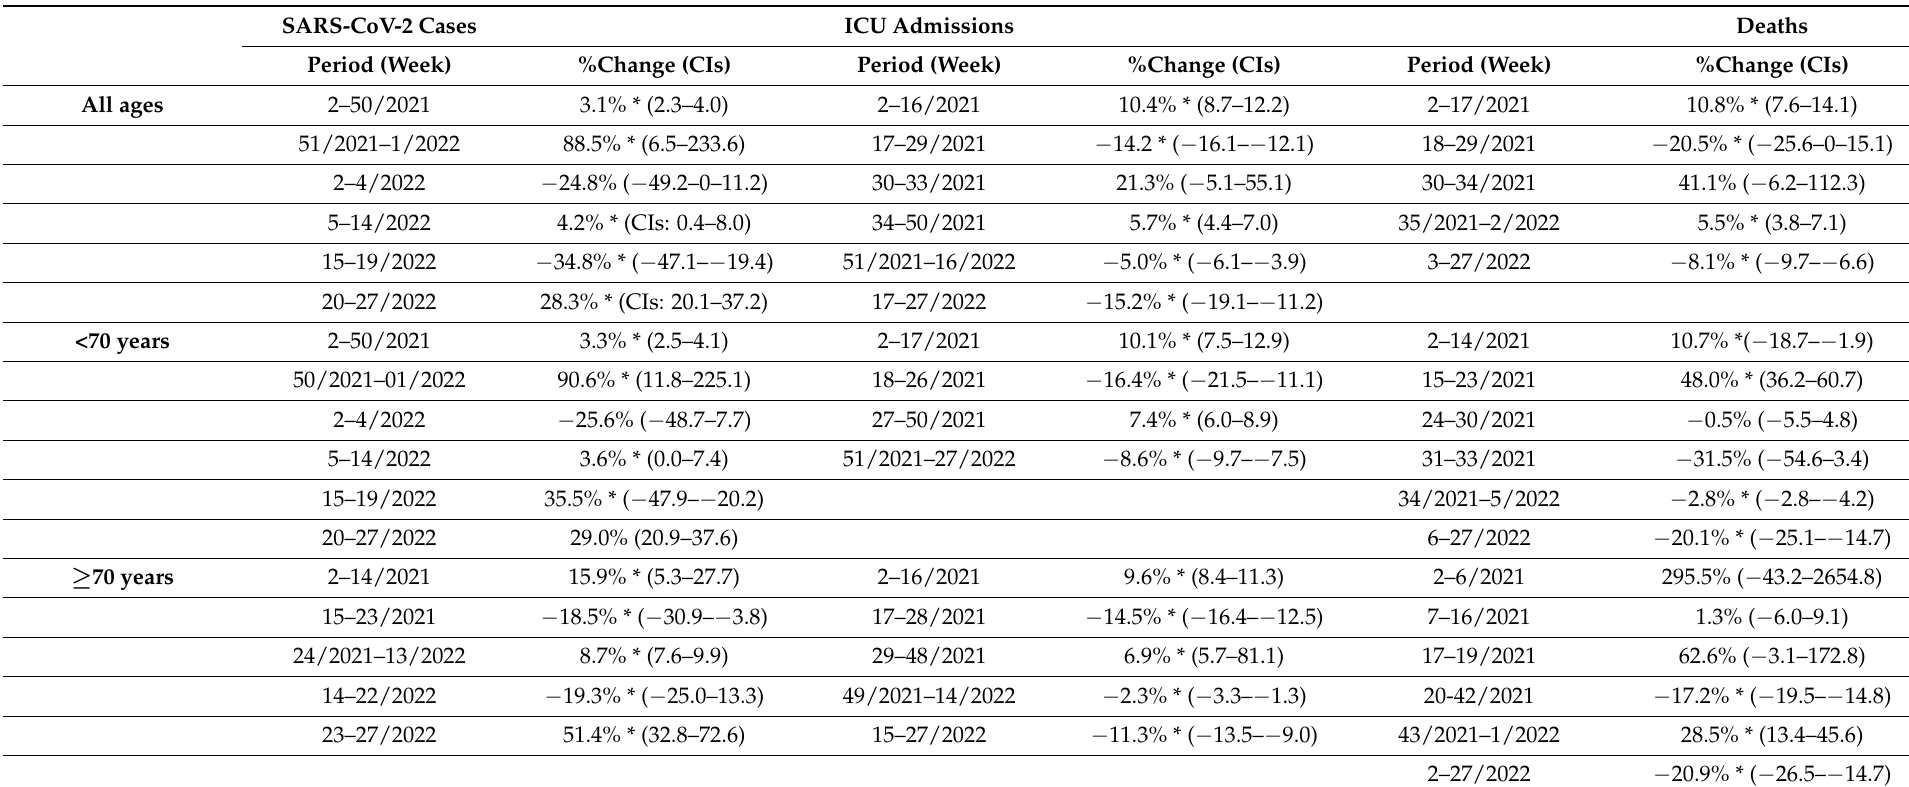
Table 2. Joinpoint regression analysis of trends in SARS-CoV-2 cases, ICU admissions and deaths stratified by age group. * p <